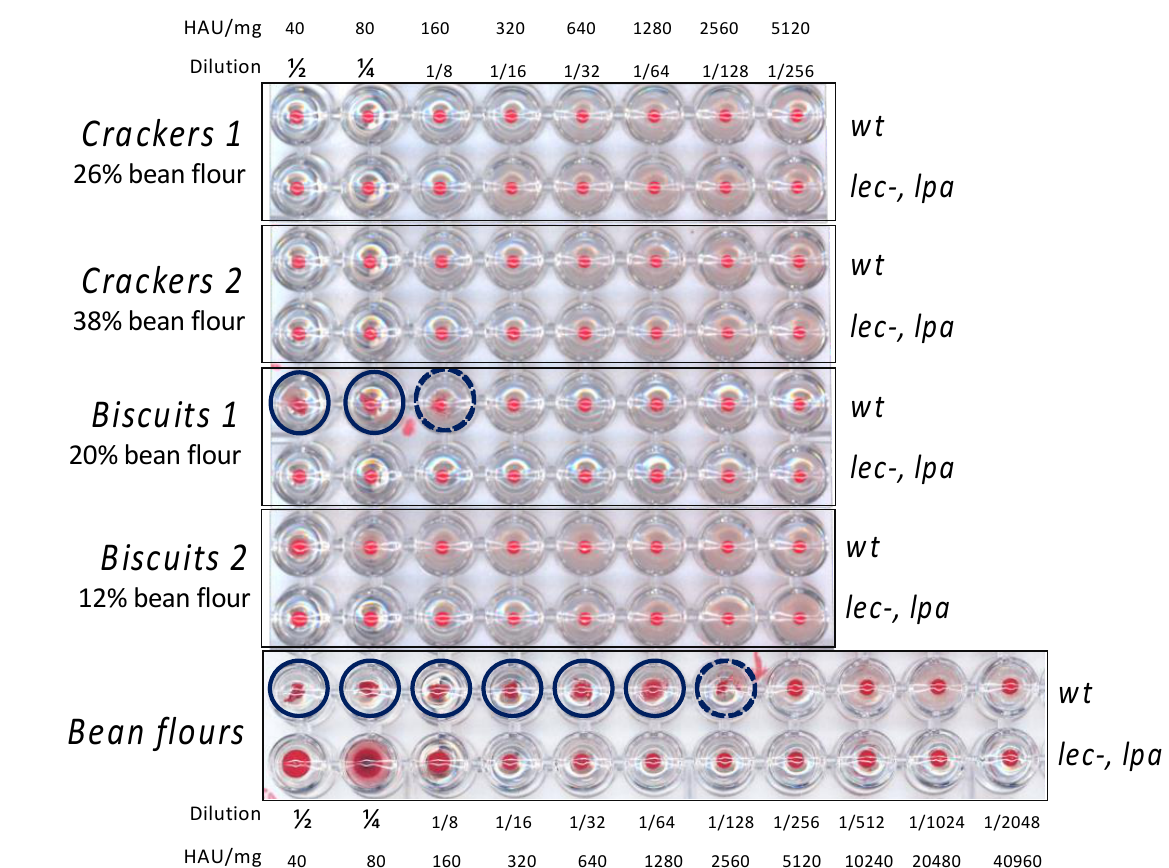
Figure 2. Hemagglutinating activity of bean-based products and bean flour extracts. Serial dilutions of equal amounts of